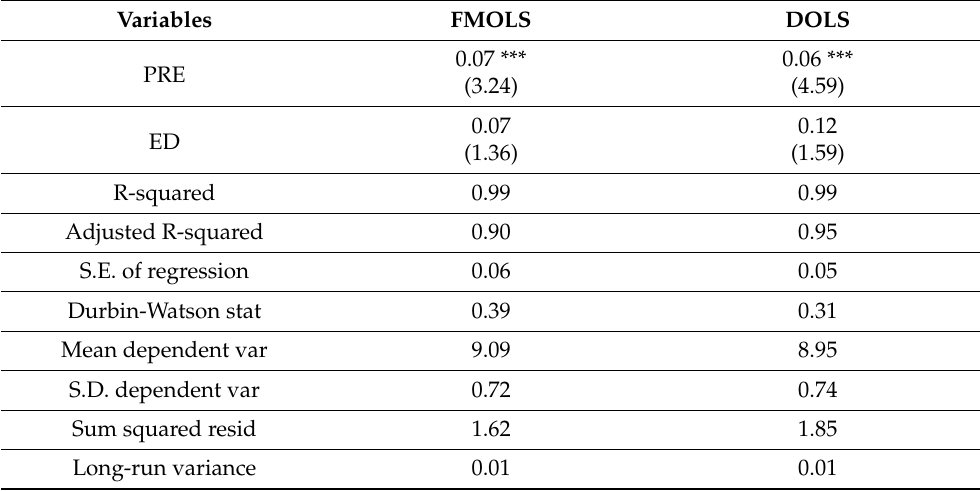
Table 9. The output of the panel fully modified OLS (FMOLS) and dynamic OLS (DOLS) models. Variables